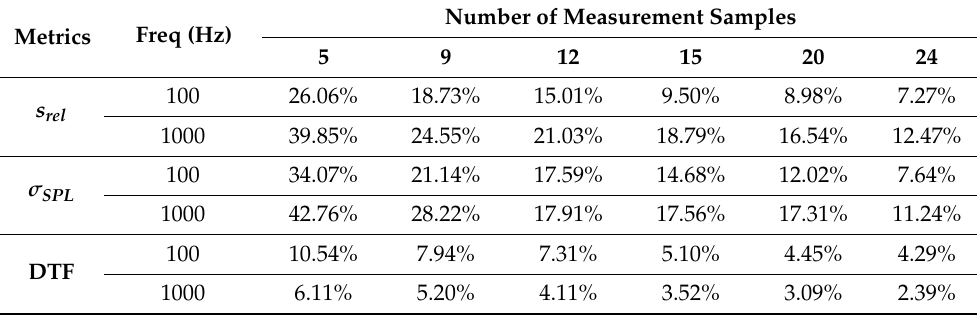
Table 3. The coefficient of variations (CV) of the diffuseness metrics at 100 Hz and 1000 Hz with a different number of measurement